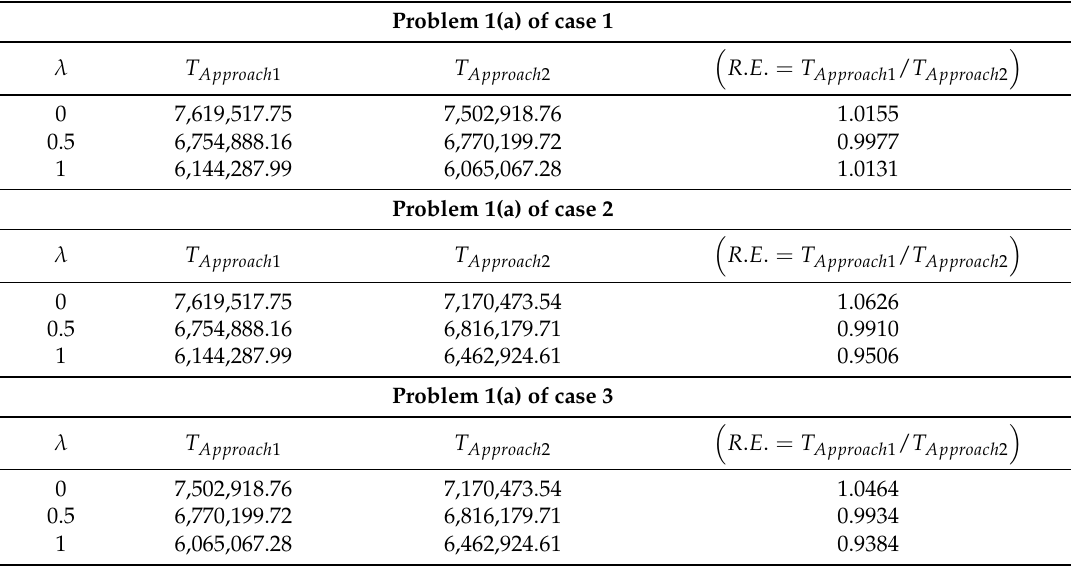
Table 15. Relative efficiency of the